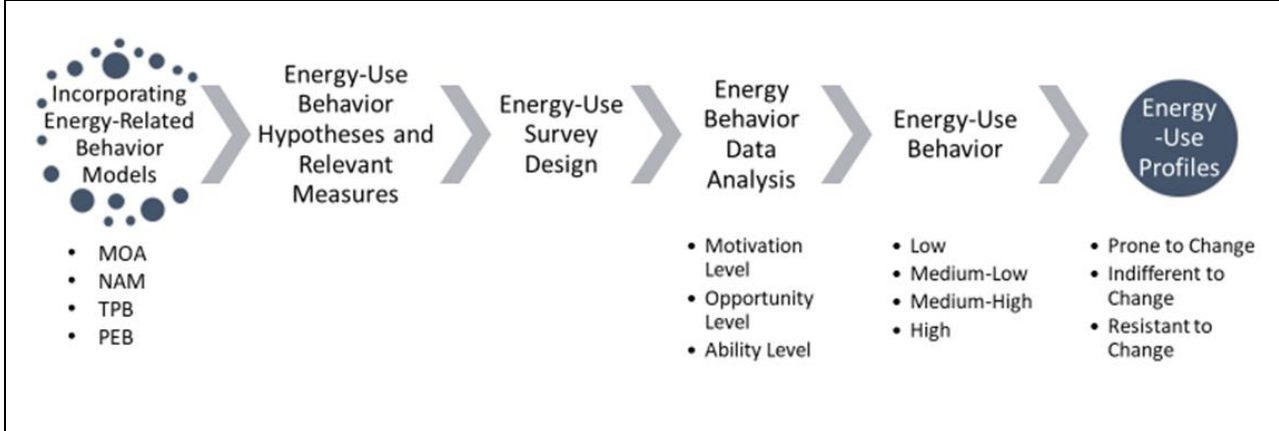
Figure 2. The Process for identifying Energy-Use Profiles of the Hotel Guests.